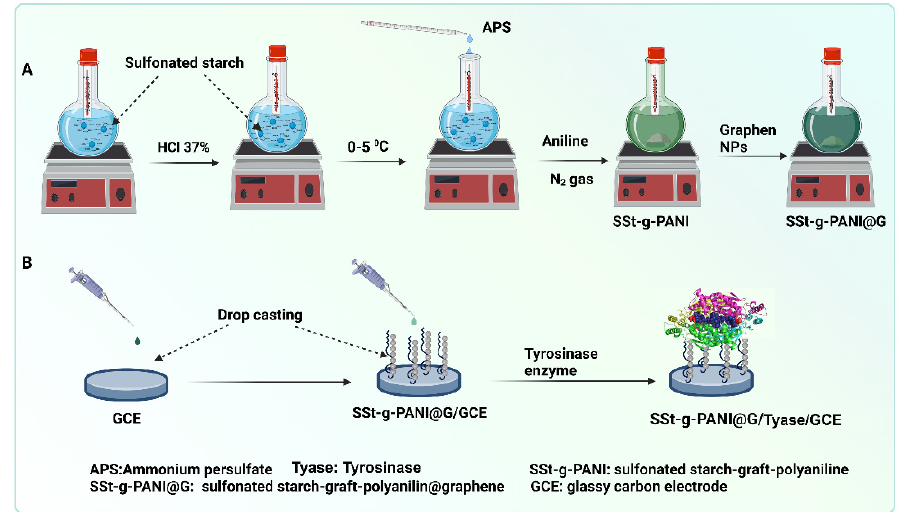
Figure 2. Schematic illustration of in situ copolymerization method for the fabrication of SSt-g- PANI@G nanocomposite ( A ) and electrode fabrication and enzyme immobilization method ( B ).